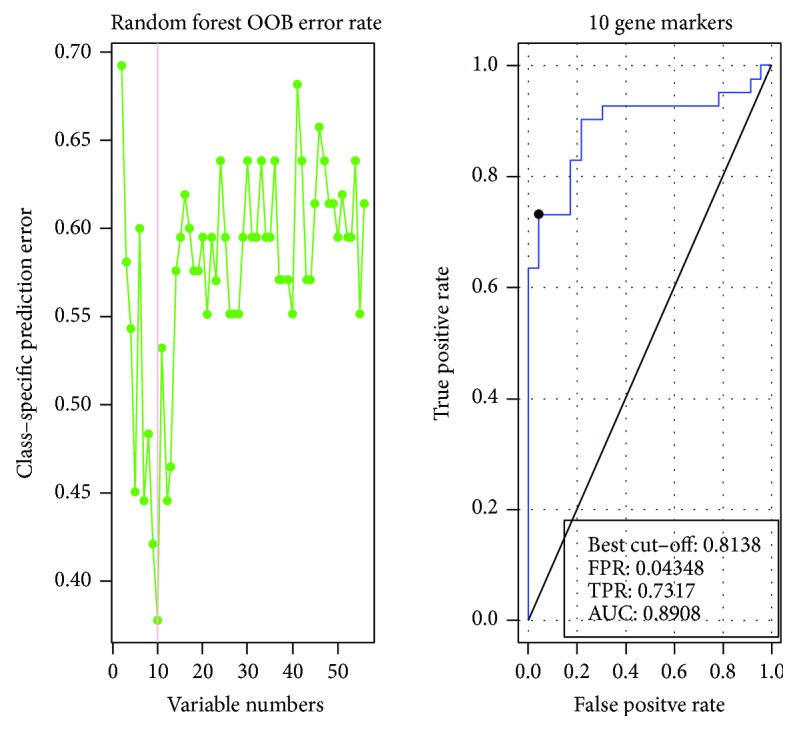
Classification based on mOTU marker in CRC cases and controls.